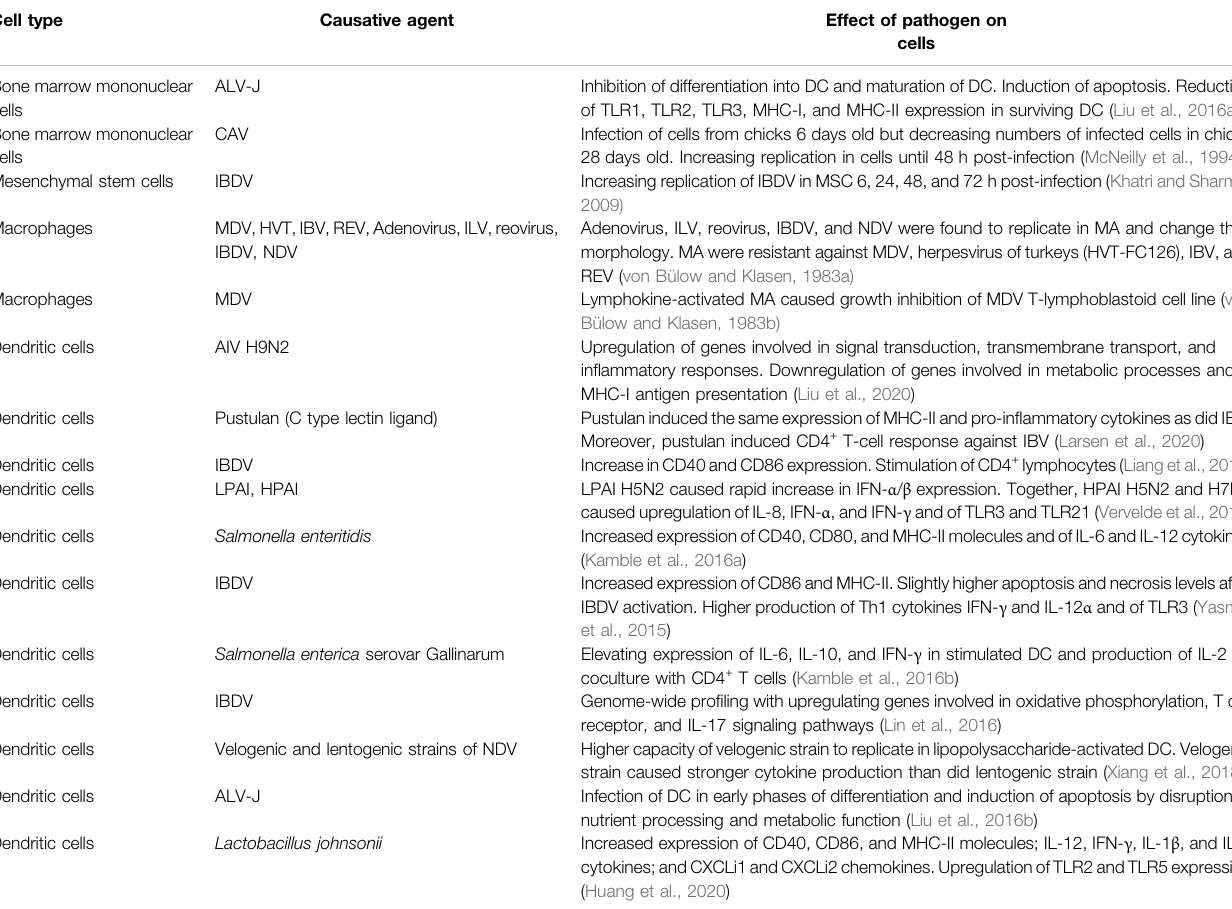
TABLE 2 | Effects of avian diseases on avian bone marrow-derived cells in in vitro